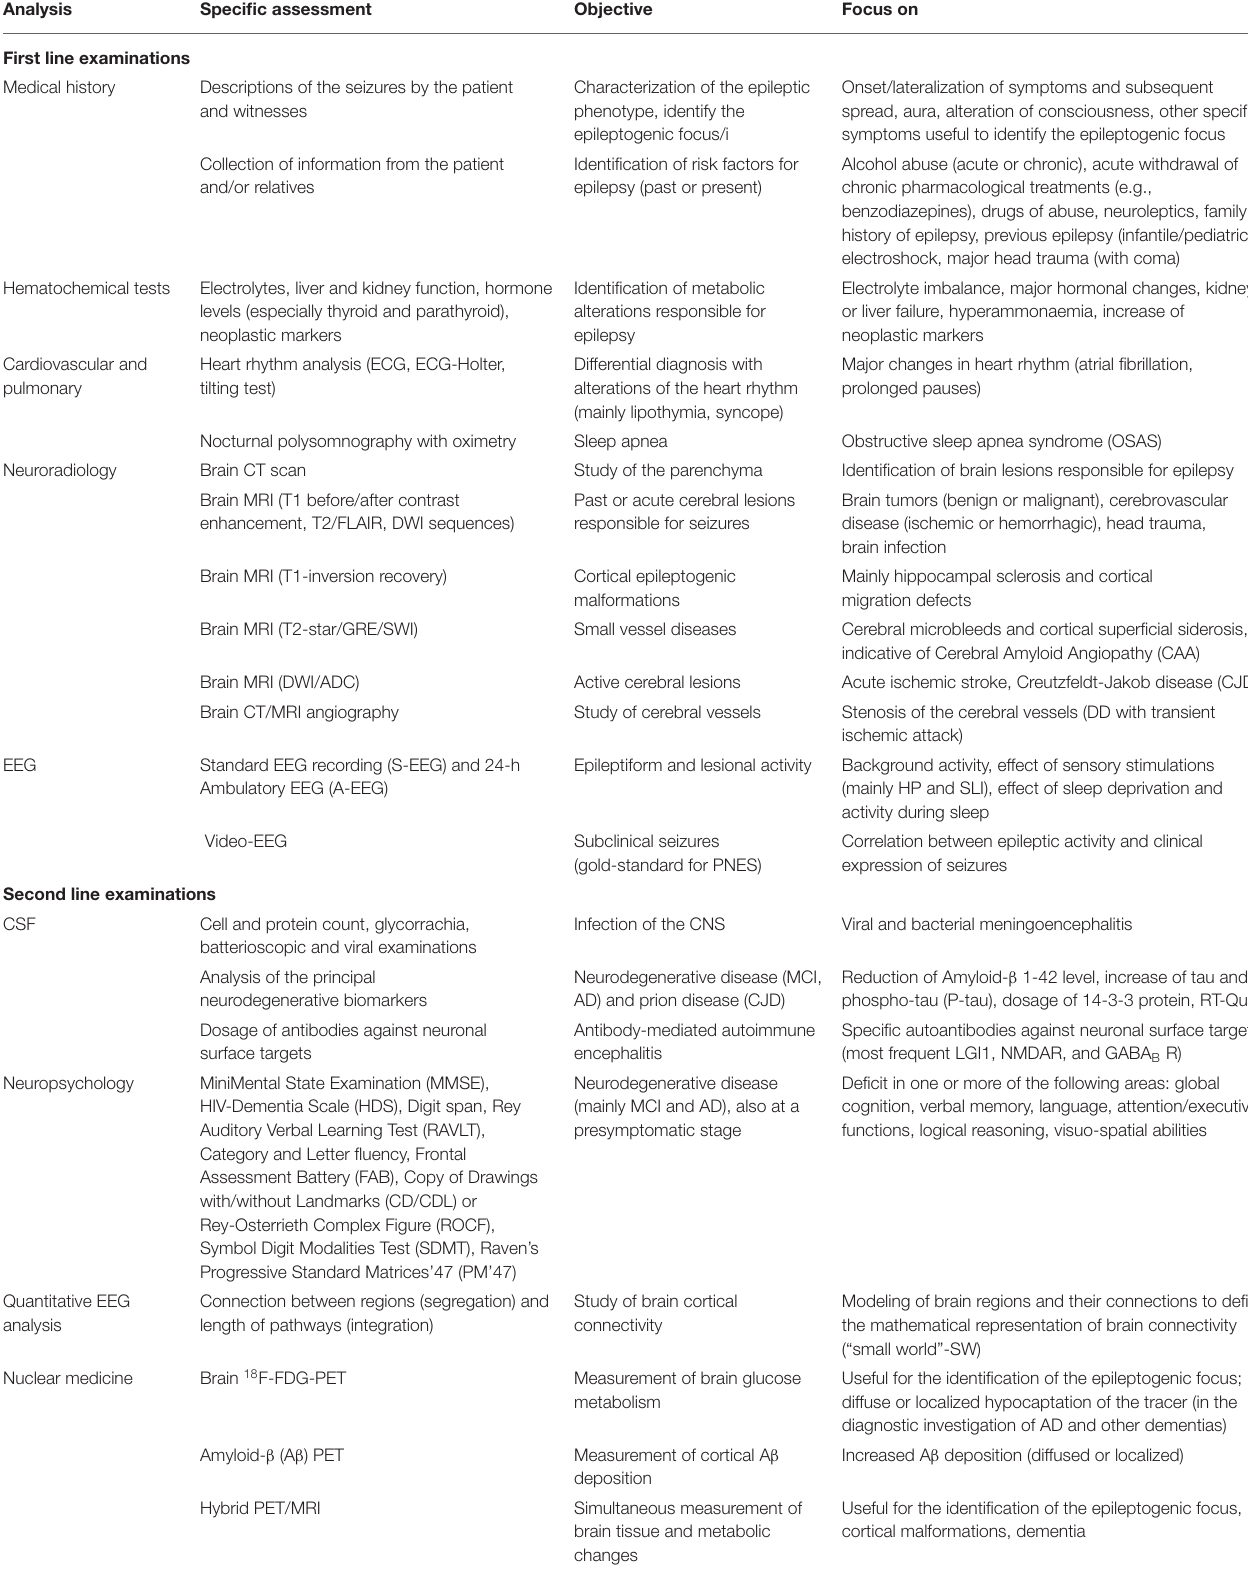
TABLE 1 | Characterization of patients with late-onset